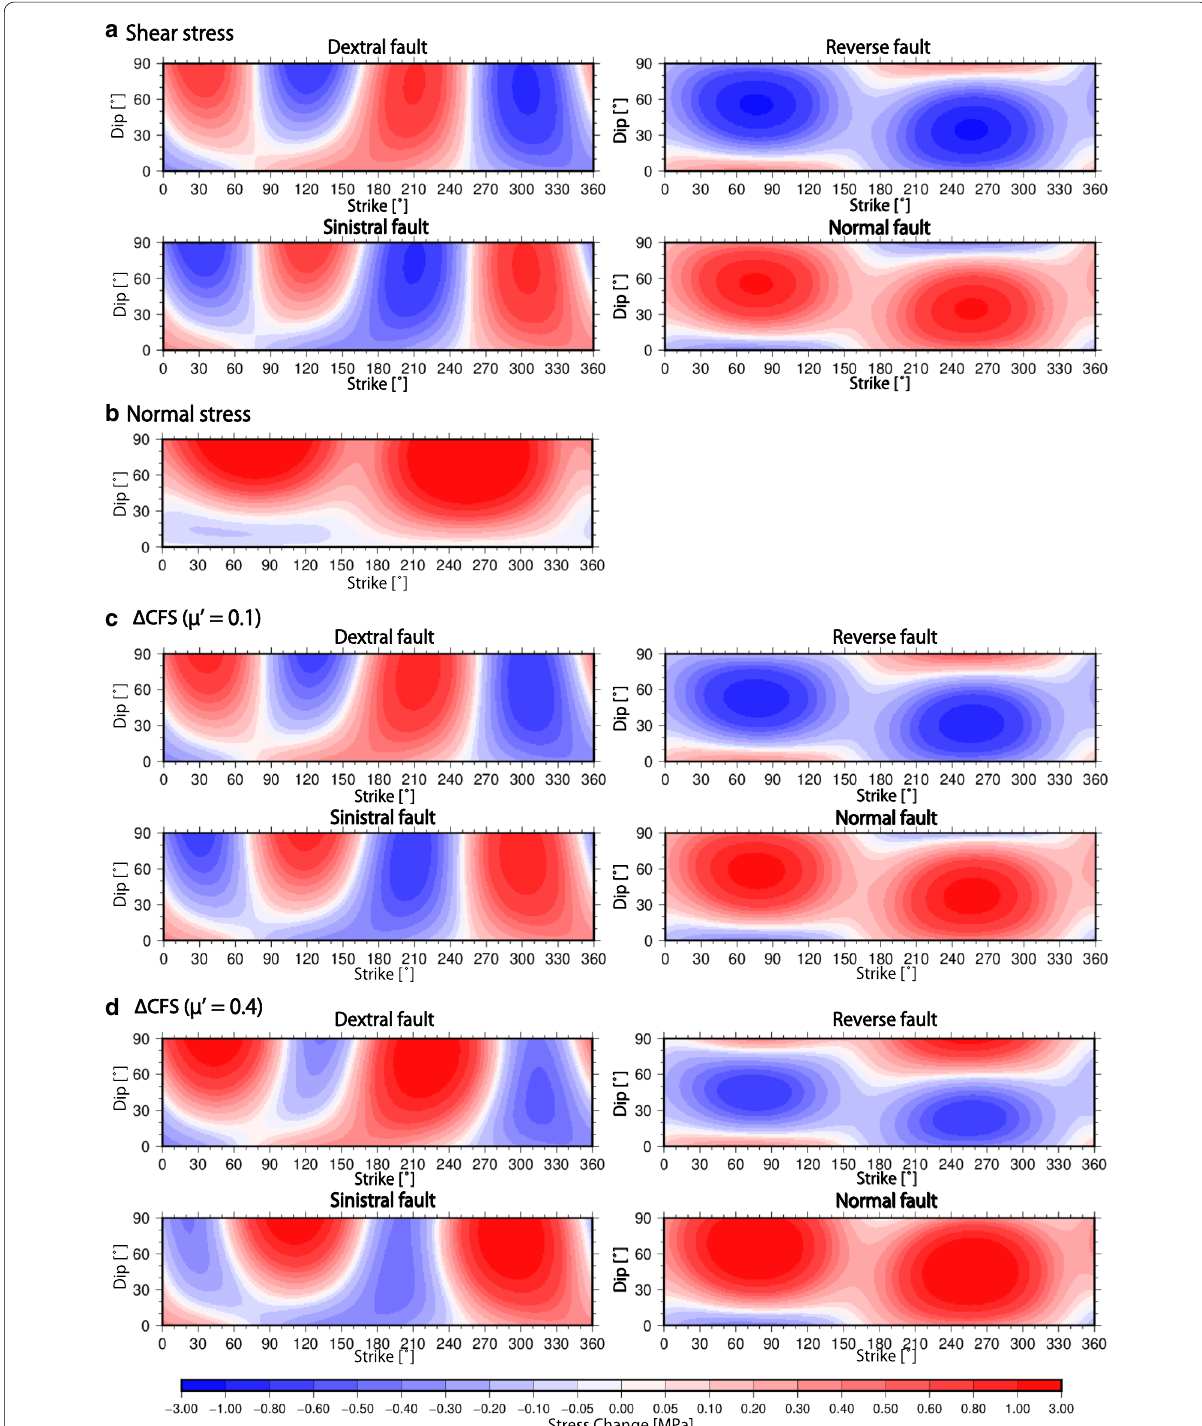
Fig. 2 Coseismic stress changes on an inland fault with varying strike and dip. The inland fault is located 150 km from the upper‑edge of the megathrust fault. The rake of the dextral fault, sinistral fault, reverse fault, and normal fault for calculating the shear stress and (cid:31) CFS are 180°, 0°, 90°, and 90°, respectively. a Shear stress change, b normal stress change, c (cid:31) CFS with an apparent friction coefficient of 0.1, and d (cid:31) CFS with an − apparent friction coefficient of